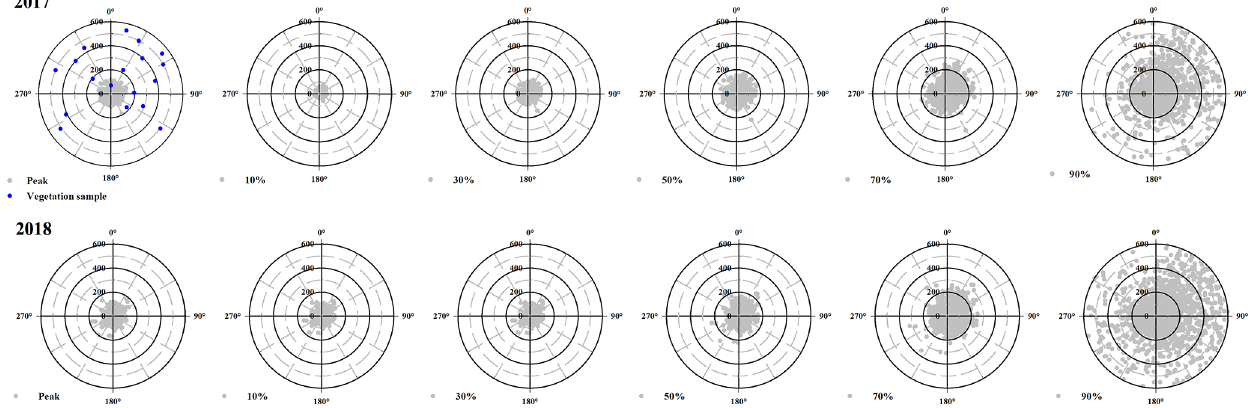
Figure 2. Source strength-weighted function at the Bernal site during 2017 and 2018 (gray points). Horizontally, plots show the peak of the function and increasing percentages of the flux footprint. The radial scale is along-wind distance from the sensor (m). The measurement height was 6m. The blue points represent the vegetation sample plots used to calculate the importance vegetation index (IVI).